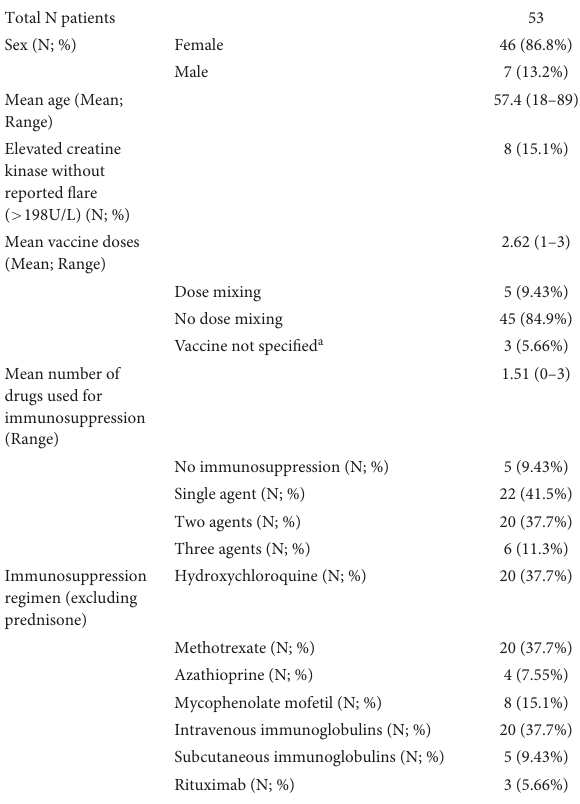
TABLE 1 Demographic summary of all dermatomyositis